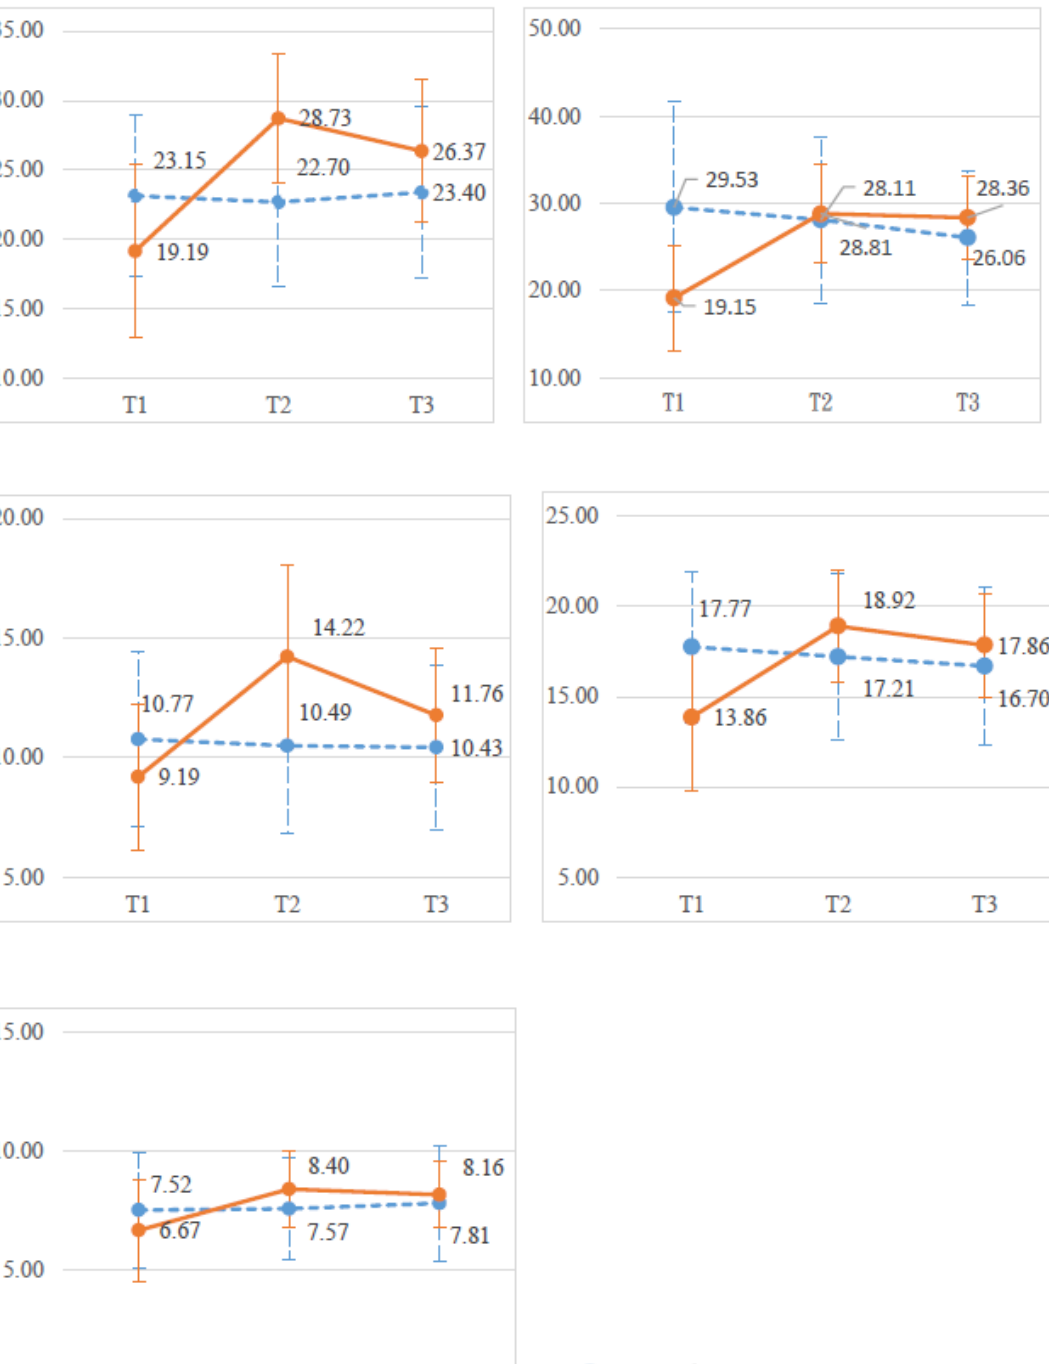
Figure 3. Changes in outcome variables between the experimental group and the control group at 3 time points for (1) health status, (2) meaning